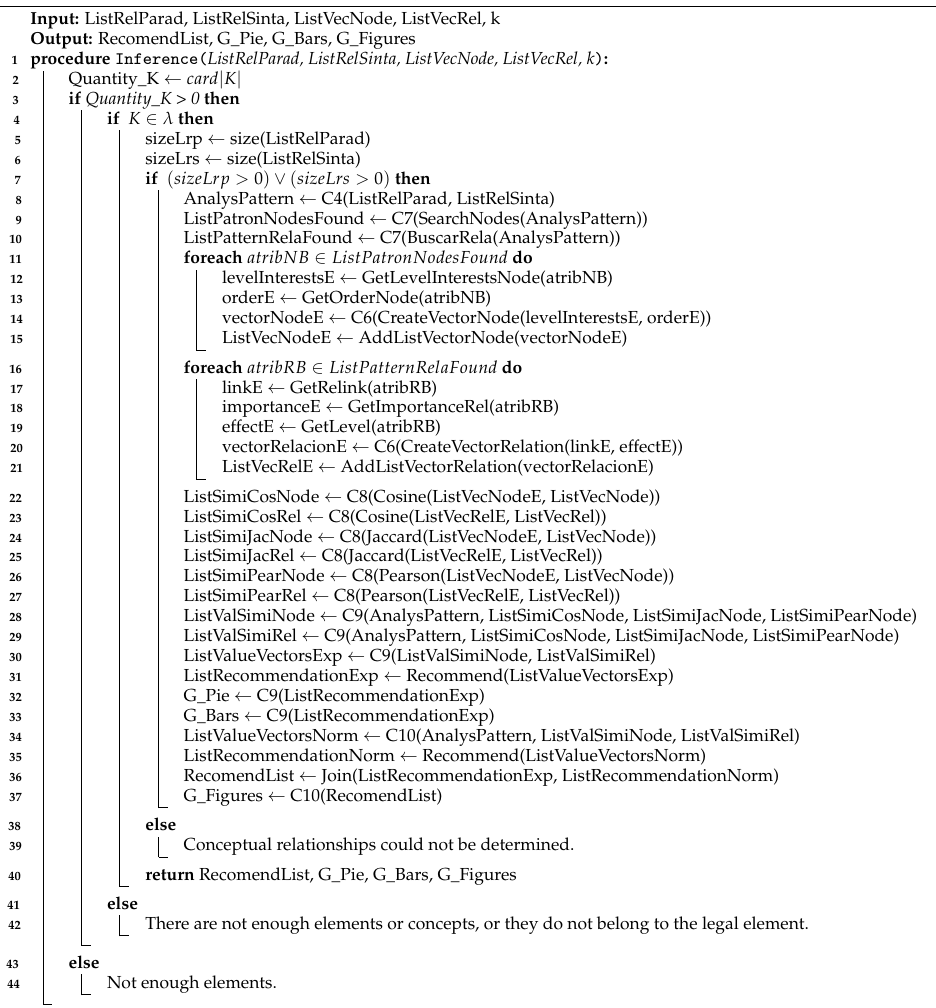
Algorithm 2: KG legal inference using Cosine, Jaccard, and Pearson